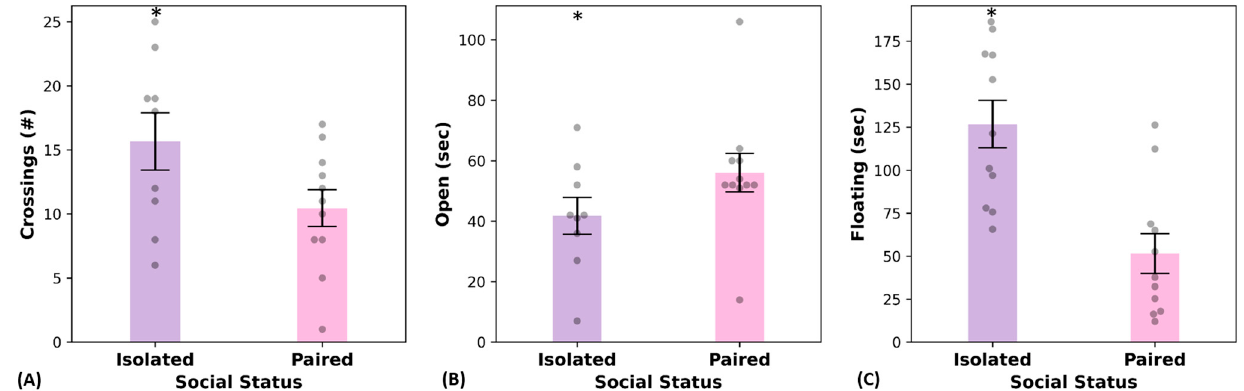
Figure 1. When placed in the elevated plus maze, socially isolated prairie voles exhibited behaviors associated with hyperactivity, anxiety, and depression. ( A ) Isolated voles exhibited a greater number of center crosses (N = 9, M = 15.667, SEM 2.224) than paired voles (N = 11, M = 10.45, SEM = 1.436). ( B ) Isolated voles spent less time in the open arms of the EPM (N = 9, M = 41.778, SEM = 6.105) than paired voles (N = 11, M = 56.091, SEM = 6.362). ( C ) When placed in the FST, isolated voles exhibited increased immobility (N = 11, M = 126.8, SEM = 13.8) compared to paired voles (N = 11, M = 51.5, SEM, 11.7). * denotes statistically significant differences ( p < 0.05)